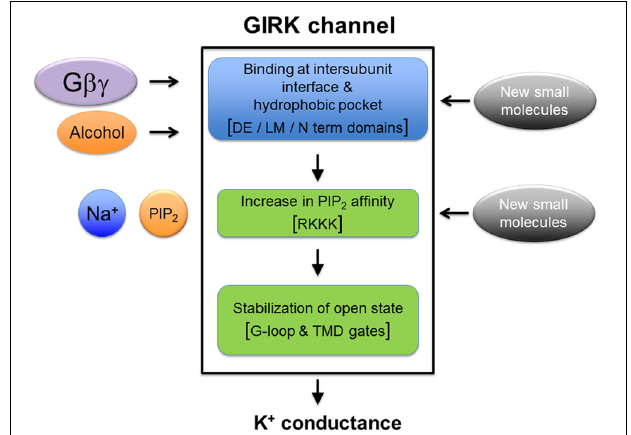
FIGURE 2 | Working model of GIRK channel gating. Alcohol binds directly to the alcohol pocket and G βγ binds very close to the alcohol pocket. The binding leads to multi-domain conformation changes that culminate in stabilization of the PIP 2 -bound open state of GIRK channel; involving increase in PIP 2 -GIRK affinity (Bodhinathan and Slesinger, 2013) and possibly involving structural changes to the PIP 2 binding site described in Figure 1 . In addition, small molecule modulators of GIRK channel can possibly interact with the alcohol binding site, or may directly stabilize PIP 2 -bound open state of the GIRK channels. These events lead to the movement and opening of the G loop and the transmembrane gates, the final step of activation leading to K + ion permeation through the GIRK channel